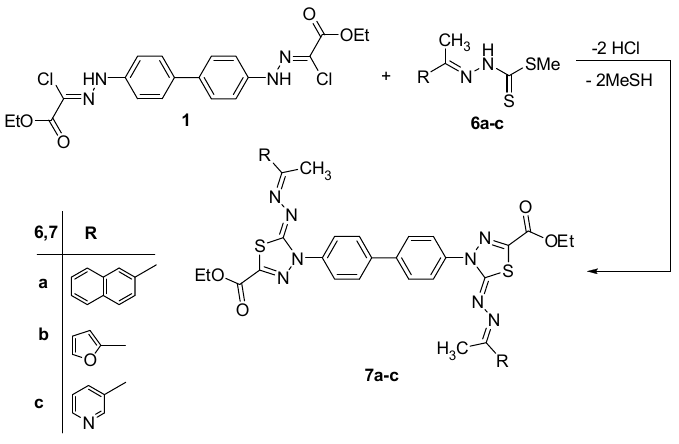
Scheme 2. Synthesis of bis -thiadiazole derivatives 7a – c